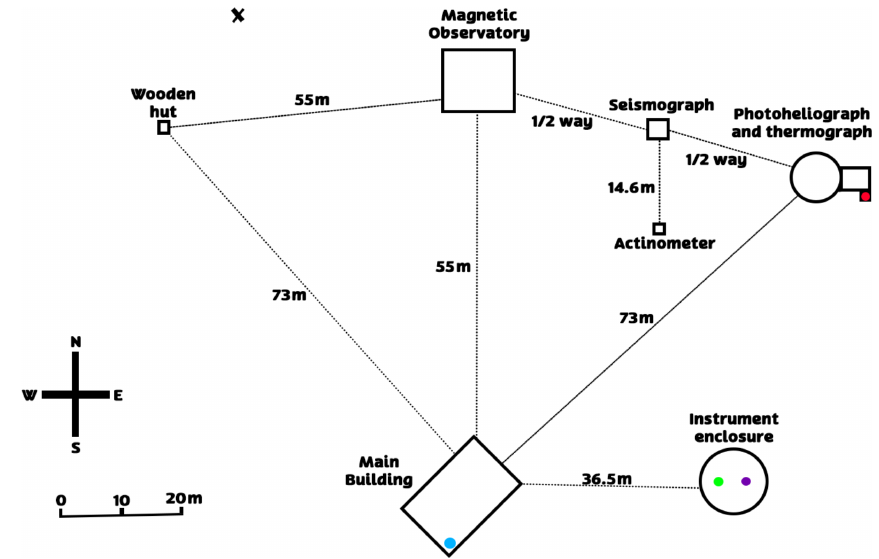
Figure 6. Rough sketch based upon the available positional metadata in later blue book entries of the layout of the site. Coloured dots denote the position of the four principal instrument configurations. Light blue – well-ventilated room (main building), green – Stevenson screen (instrument enclosure), purple – hygrometer (instrument enclosure), and red – thermograph (photoheliograph and thermograph building). It is probable that the wooden hut is in the right of the frame in Fig. 4, placing the camera to the NNW of the main building and NE of the wooden hut (marked by X as an approximate estimate). Figure 4 highlights considerable vegetation, but metadata on vegetation positioning and change through time do not exist.